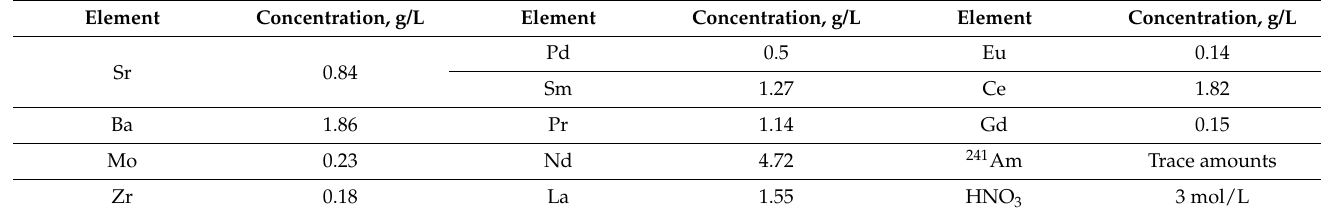
Table 3. Composition of the HLW imitator solution used in this work [18].